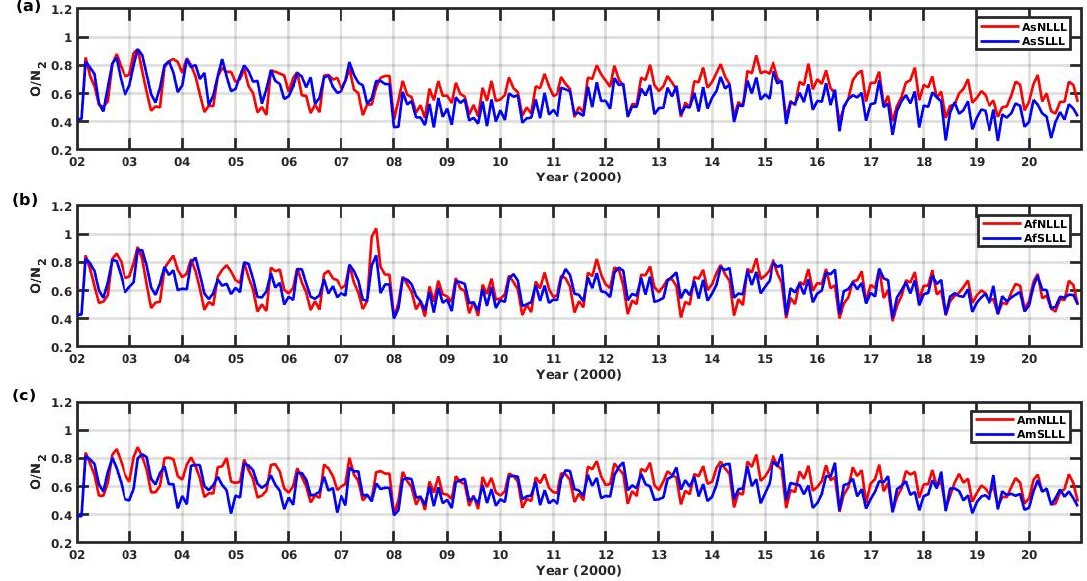
Figure 4. Similar to Figure 1a but for ( a ) Asian, ( b ) African, and ( c ) American regions.